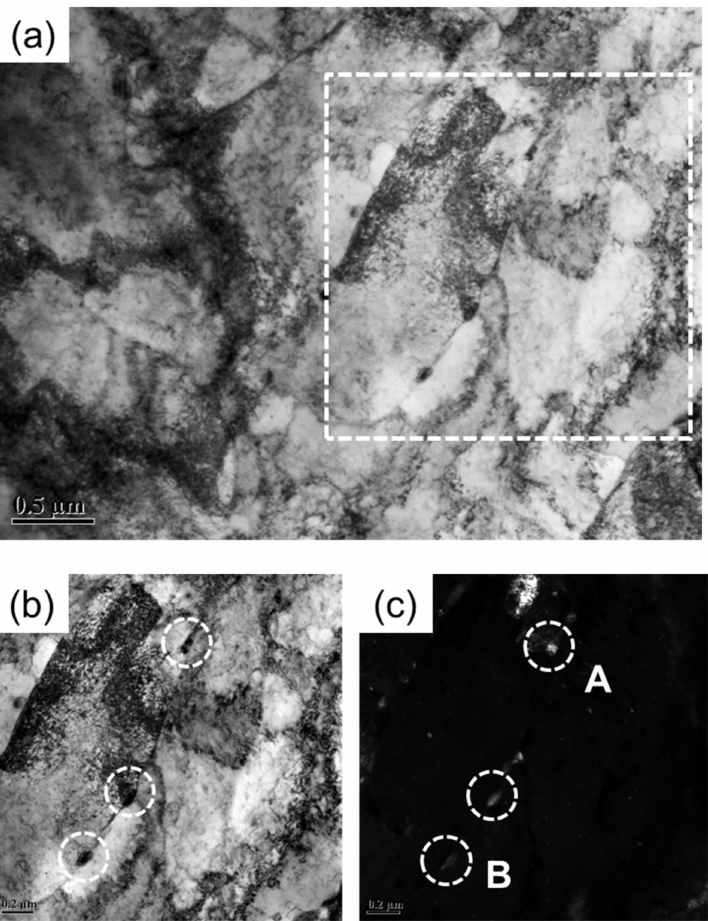
Figure 4. TEM observations of deformed matrix and precipitates in Cu-bearing steel. ( a ) General view of sub-structures; ( b ) bright-field image; ( c ) dark-field image, A and B showing the typi- cal